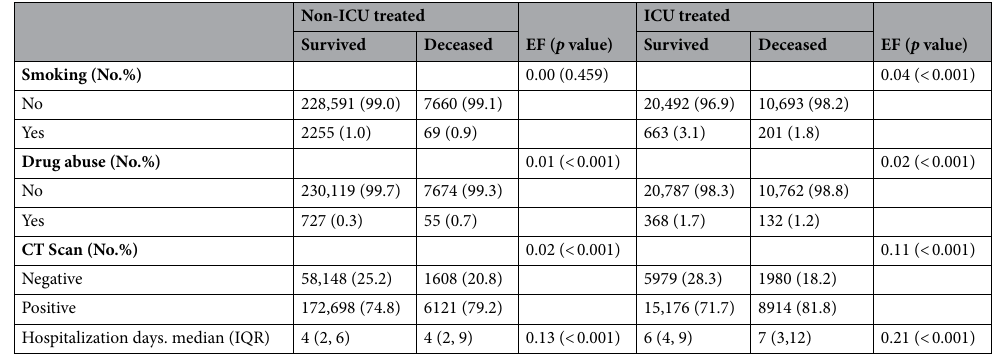
Table 2. Patient characteristics stratified by Ward. Note: The strength of relationship between categorical variable and outcome (survived and deceased) was presented using Cramer’s V. The measure of association between continuous variable and outcome (survived and deceased) was showed using Eta method. Abbreviation: Effect size (EF), intensive care unit (ICU).